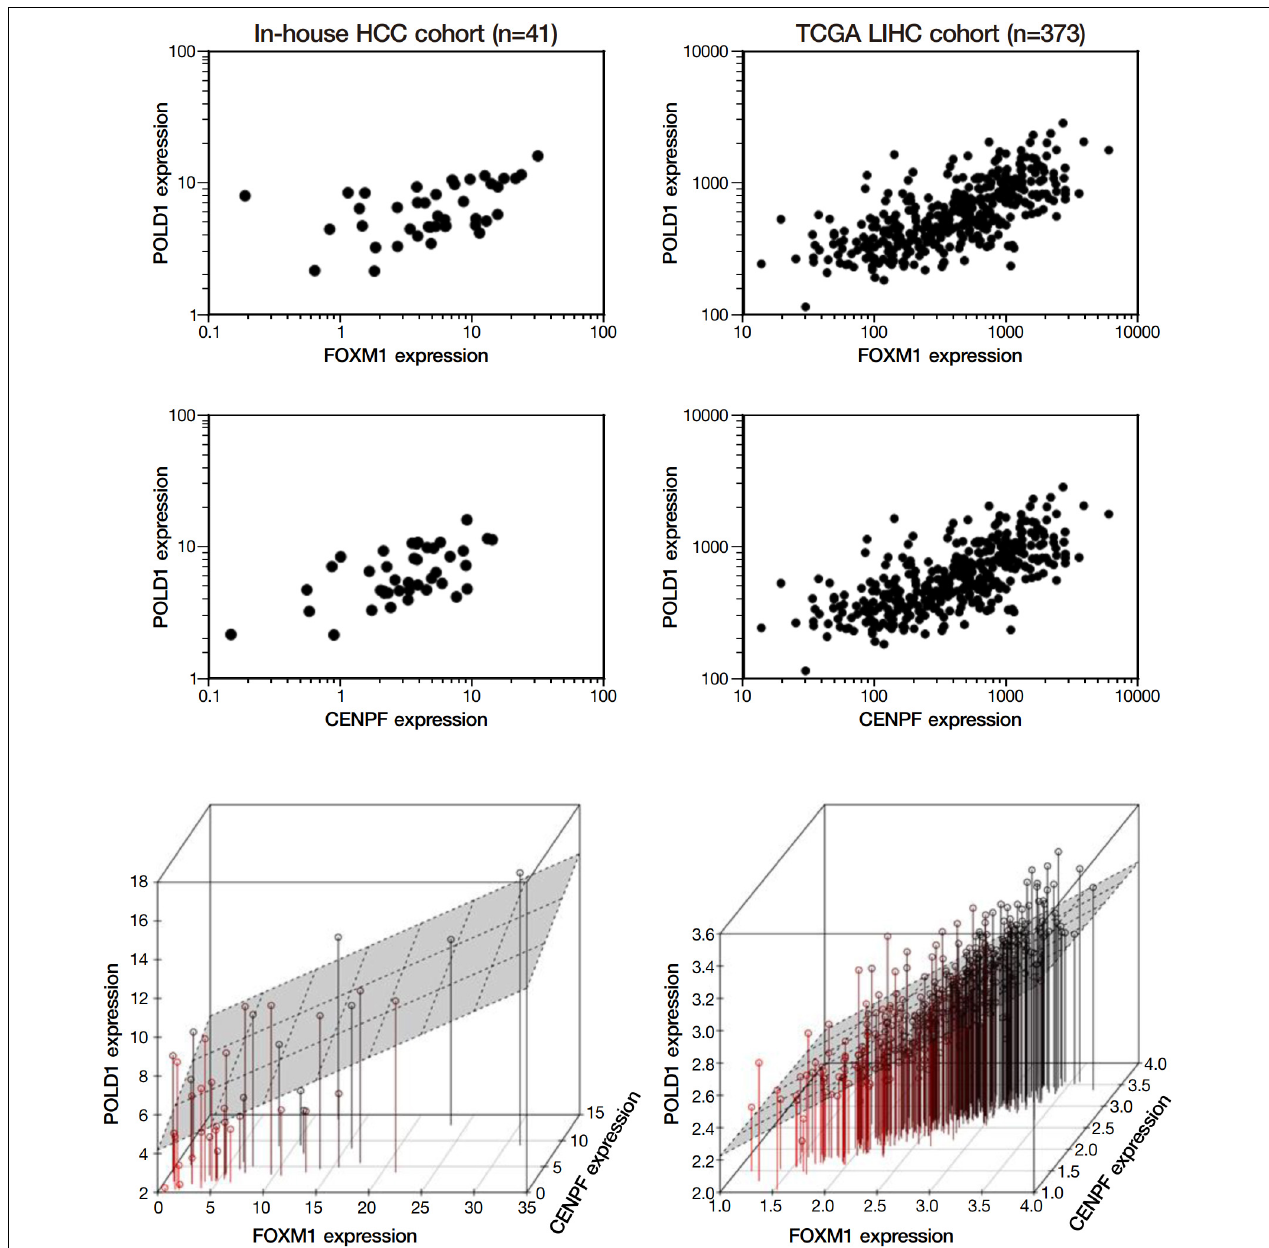
FIGURE 4 | POLD1 was positively correlated with FOXM1 and CENPF. Correlation analysis among the list of repressed candidate genes using our in-house RNA-seq dataset and the TCGA RNA-seq dataset. Both analyses indicated POLD1 was significantly correlated to both FOXM1 and CENPF ( p < 0.05). Three-dimensional plot showed the correlation between the expressions of FOXM1, CENPF and POLD1 in both